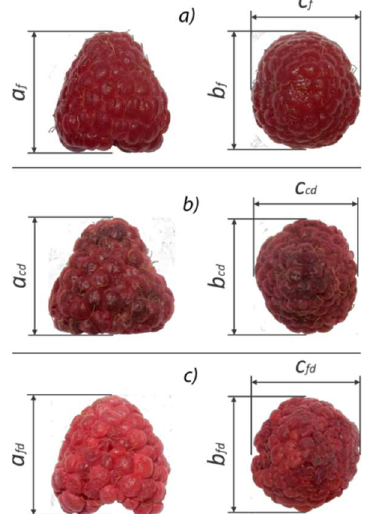
Figure 2. Red raspberry, variety Polana: ( a ) fresh (a f = 20.74±2.45mm; b f = 20.04 ± 1.96 mm; c f = 18.88 ± 1.72 mm), ( b ) after convective drying of fresh raspberry at T = 60 °C and air velocity of 1.5 m·s −1 (a cd = 16.97 ± 1.86 mm; b cd = 15.37 ± 1.65 mm; c cd = 15.34 ± 1.43 mm), and ( c ) after freeze-drying (a fd = 20.62 ± 1.98 mm; b fd = 20.62 ± 2.66 mm; c fd = 18.58 ± 1.78 mm).